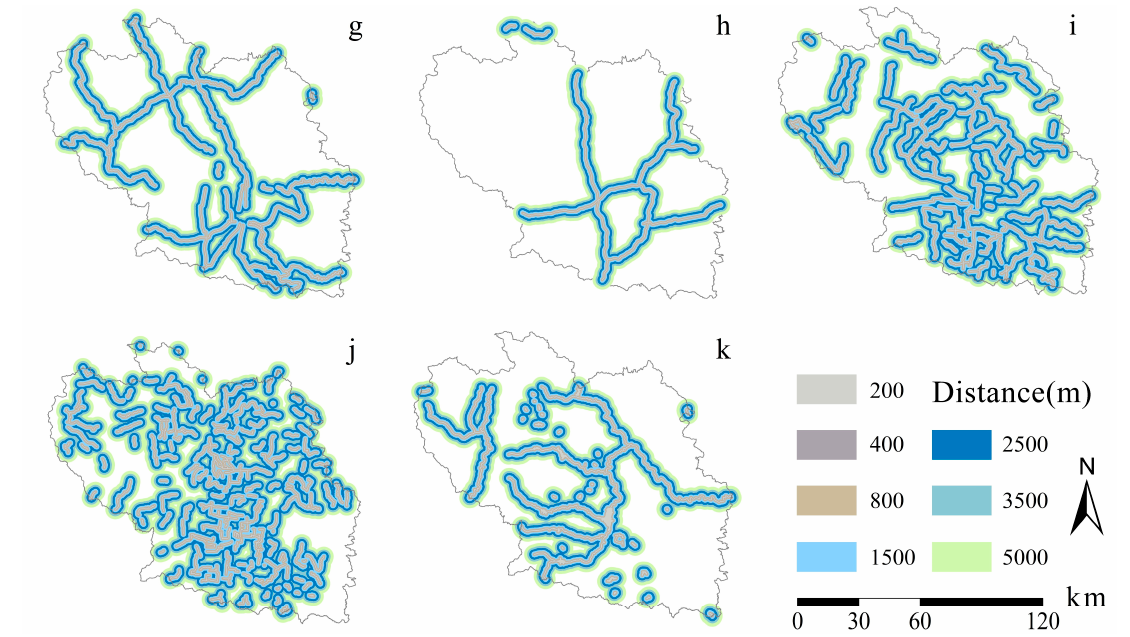
Figure 10. Map of urban spatial location buffer zone. ( a ) city center; ( b ) county center, ( c ) rivers, ( d ) settlements, ( e ) railways, ( f ) National roads, ( g ) provincial roads, ( h ) expressways, ( i ) county roads, ( j ) township roads, ( k ) reservoirs. The effect of different road grades on carbon stock density is shown in Figure 11. Higher ‐ level roads correlate more strongly with lower carbon den ‐ sity, and regional carbon stock density increases with increasing road dis ‐ tance. The data show that the carbon density within 200 m around the national road is the lowest at 91.70 t/ha, and within 200 m of the provincial road is 91.05 t/ha. The carbon density within 200 m of the township road, county road, and railway are 92.94 t/ha, 92.36 t/ha, and 92.73 t/ha. Expressway has the lowest carbon density within 200 m (96.22 t/ha), and provincial roads have a